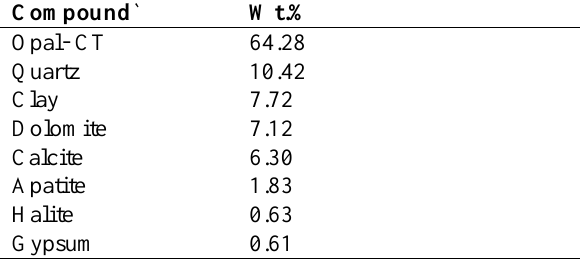
Mineral analysis of as received porcelainte stone.